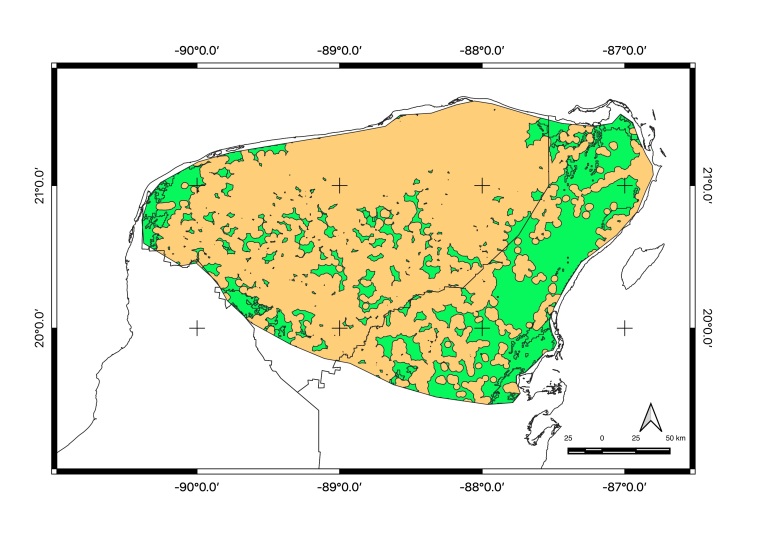
Habitat quality across the distribution of Brachypelma
epicureanum (Chamberlin, 1925). Low quality habitat areas (LQH) in orange and high quality habitat areas (HQH) in green (for estimation details, see formula in Methods).